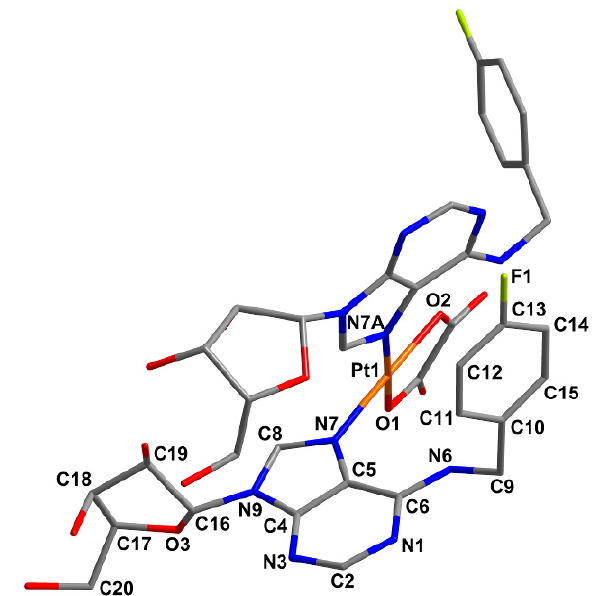
] ( 5 ) optimized using dispersion corrected DFT-D3 Figure 4. Geometry of [Pt(ox)( 4F L) 2 quantum chemical calculations performed at the B3LYP/LANLTZ/6-311G** level of theory. Hydrogen atoms are omitted for